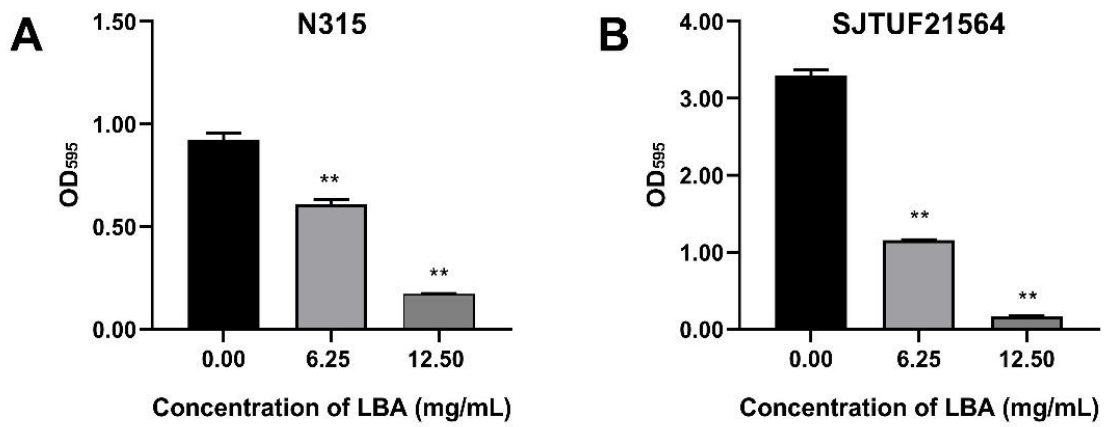
Figure 1. Effect of LBA on biofilm formation of S. aureus strain N315 ( A ) and SJTUF21564 ( B ). The values on the X-axes correspond to the following: 0.00, untreated control; 6.25, 0.5 × MIC; and 12.50, 1 × MIC. **, statistical significance at p < 0.01 by analysis of variance.